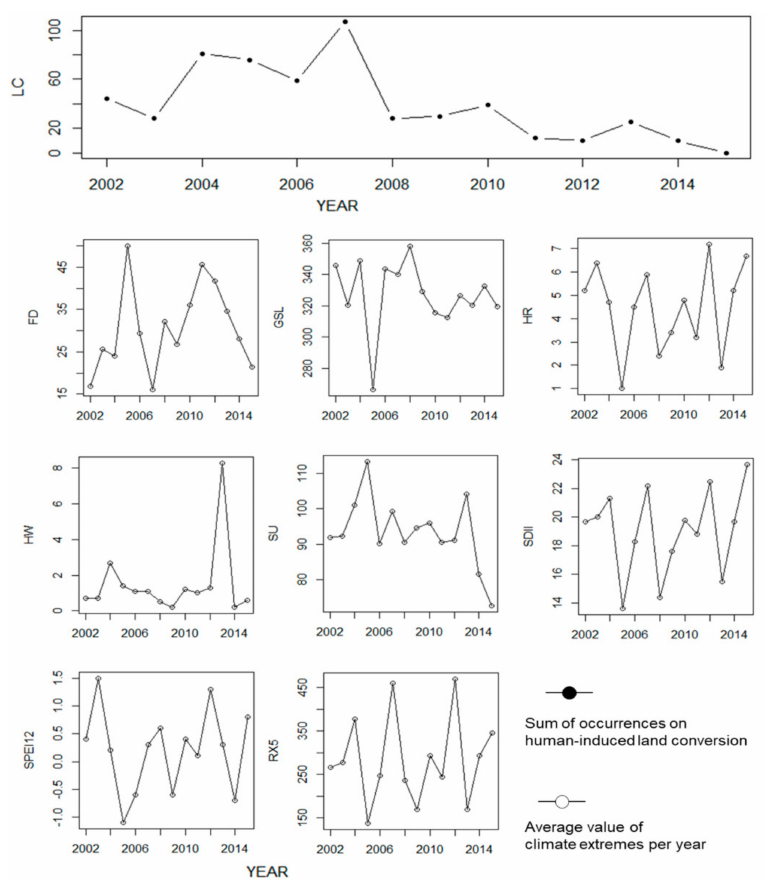
Figure 4. Trend in the occurrence of human-induced land conversion and climatic extremes. For all sample points, occurrences from 2002 to 2015 are